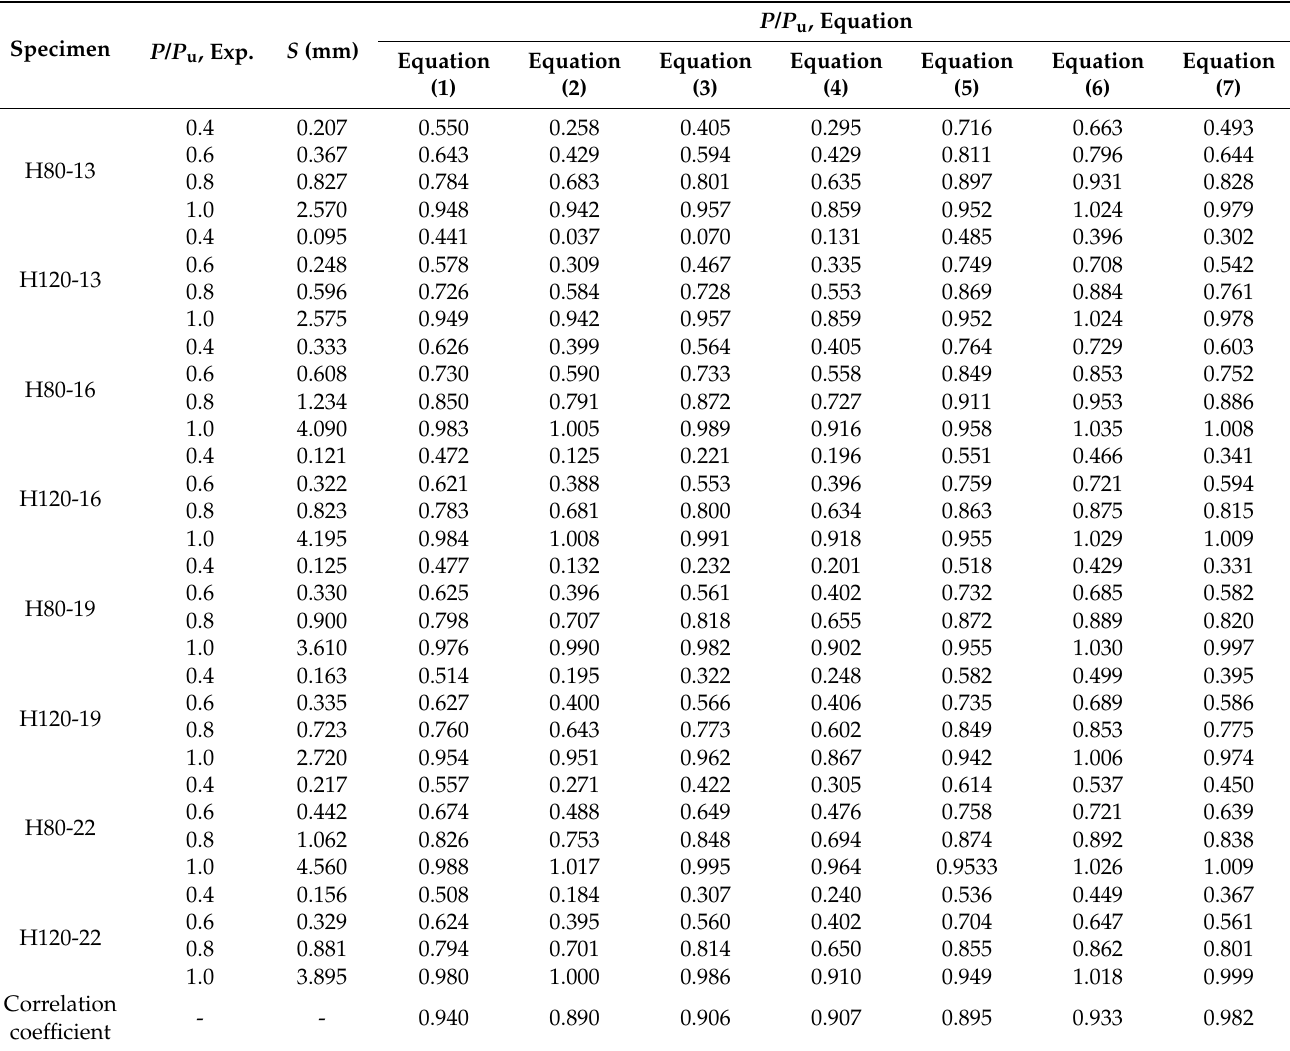
Table 6. Comparison of load-slip curves obtained by test results and prediction